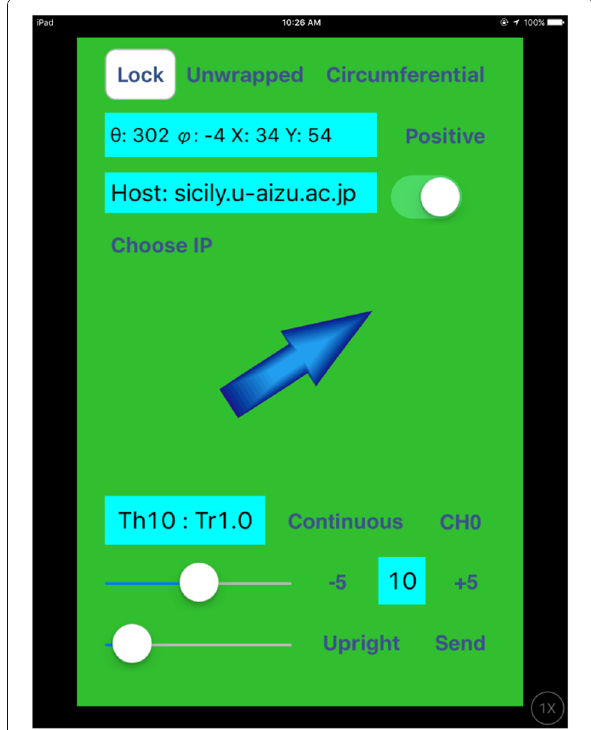
Fig. 6 Running Twhirleds app, including typical settings. (This image is for the Apple iPad tablet, but the interfaces for the iPhone smartphone, iPad mini phablet, and Android devices are similar.)